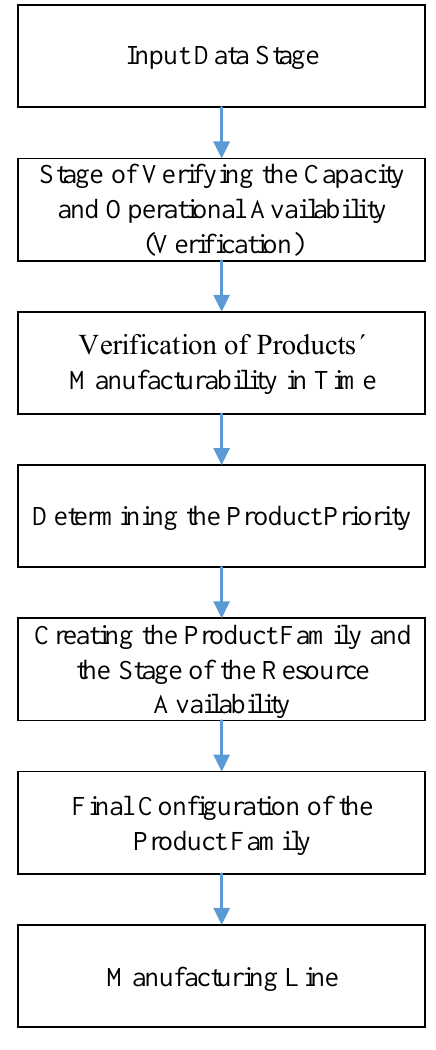
Figure 1. The methodology for the design of reconfigurable manufacture lines.